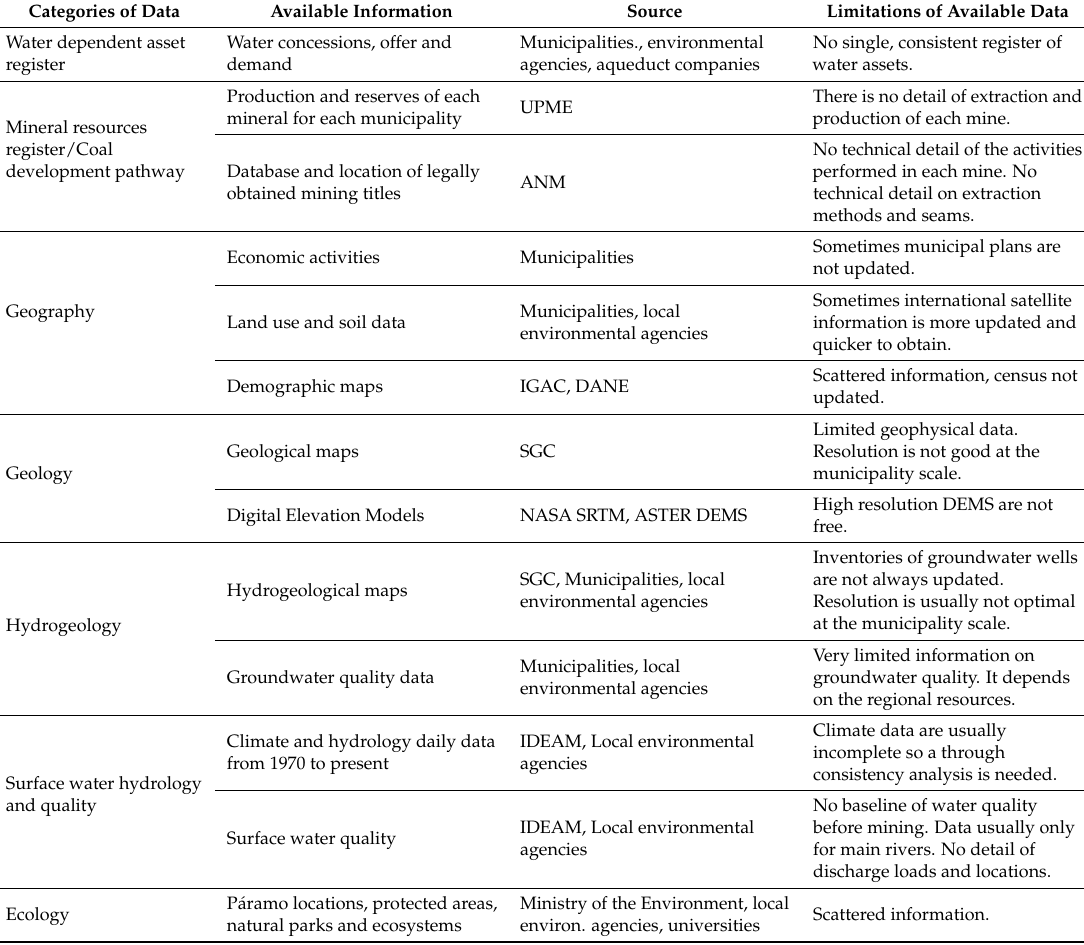
Table 2. Case study datasets and their limitations for conducting Stage 1 of the